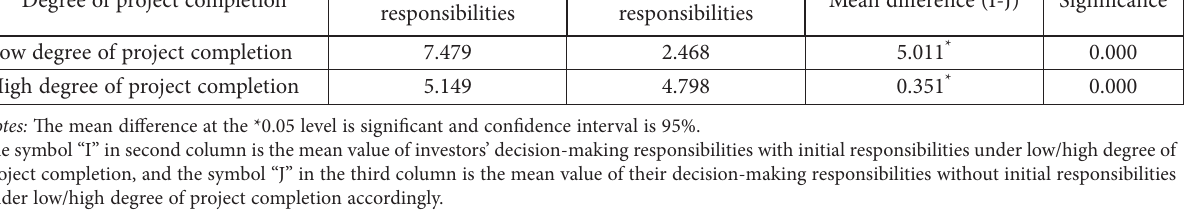
Table 1. Analysis of investors’ decision-making responsibilities under different degrees of project completion (I) With initial (J) Without initial Degree of project completion responsibilities